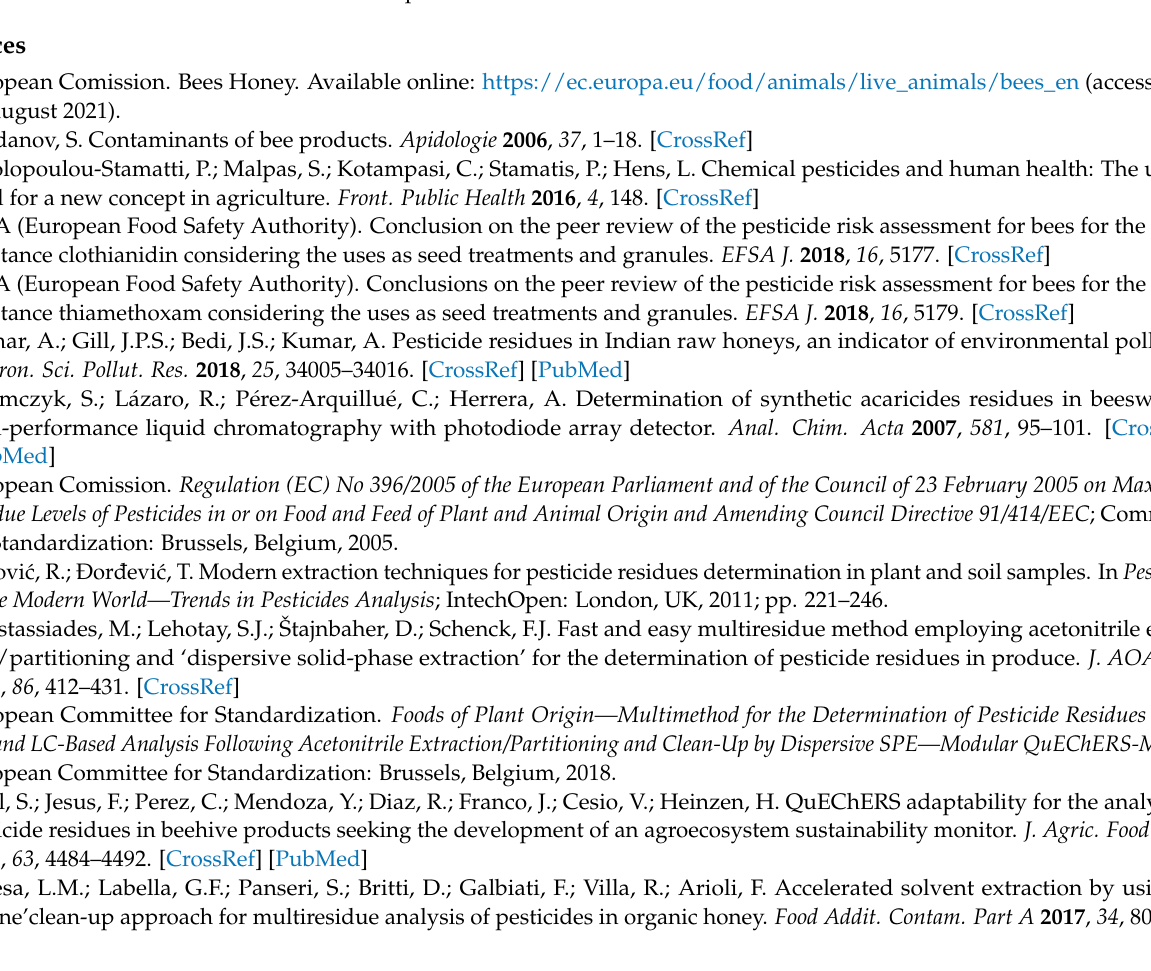
Table S2: List of Compounds Included in the LC–MS/MS method together with their Retention Times (RT), quantification and confirmation transitions, capillary voltage, and collision